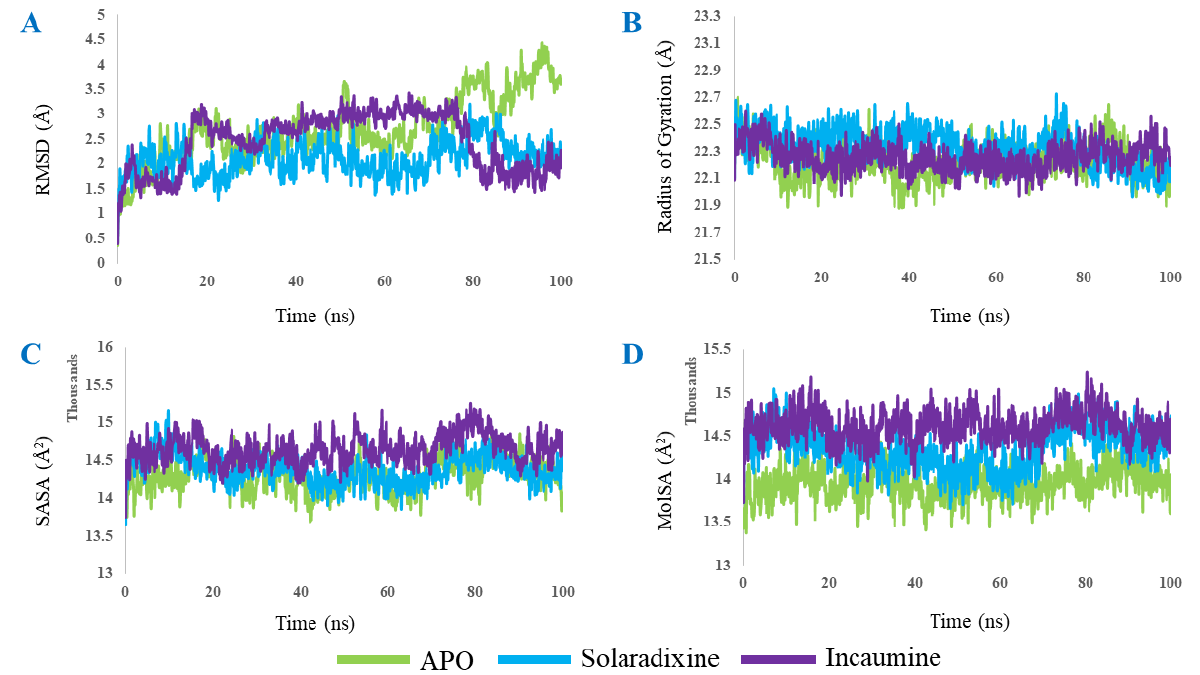
Figure 10. RMSD, radius of gyration, SASA, and MolSA values of Mpro without ligand (APO), solaradixine, and incanumine. ( A ) RMSD, or root-mean-square deviation, is a standard measure of structural distance between coordinates. ( B ) The radius of gyration (Rg) is defined as the distribution of atoms of a protein around its axis. ( C ) Solvent-accessible surface area (SASA) is the surface area of a biomolecule that is accessible to a solvent. ( D ) MolSA stands for molecular surface area.